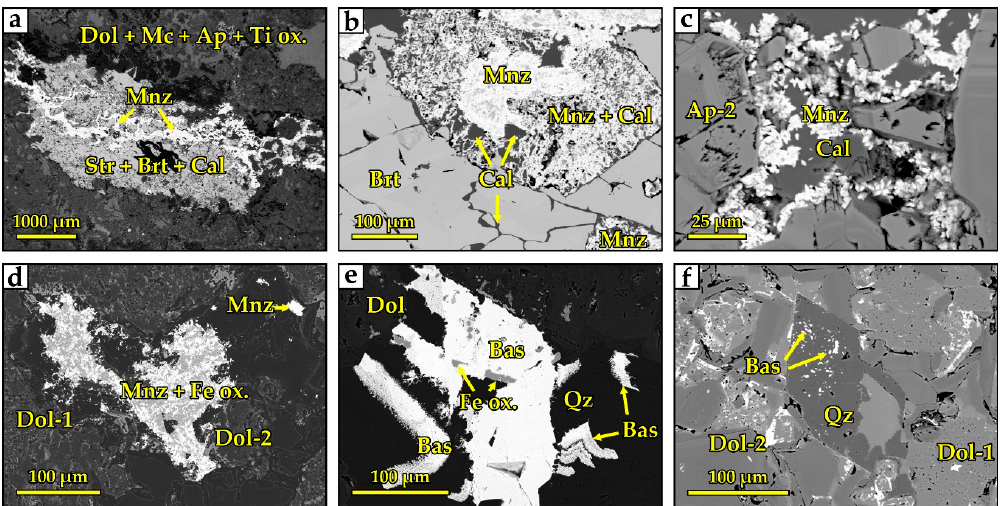
Figure 8. Secondary mineral assemblages of high-Ti carbonatites. ( a ) Baryte, ancylite, strontianite, calcite, quartz, and brookite surrounded by resorbed dolomite in a cavity. ( b ) Monazite formed near the late apatite. ( c ) A monazite vein that intersects a cavity with baryte–strontianite mineralization. ( d ) Partial replacement of dolomite with clusters of monazite and iron oxides. ( e ) Porous bastnäsite in association with collomorphic quartz cementing the latest cracks. ( f ) bastnäsite microinclusions in Table 2. Assignment of the vibrations of the main bands and their Raman frequencies (cm − 1 ) for monazite, rhabdophane, calcite, bastnäsite, and hydroxylbastnäsite. Band